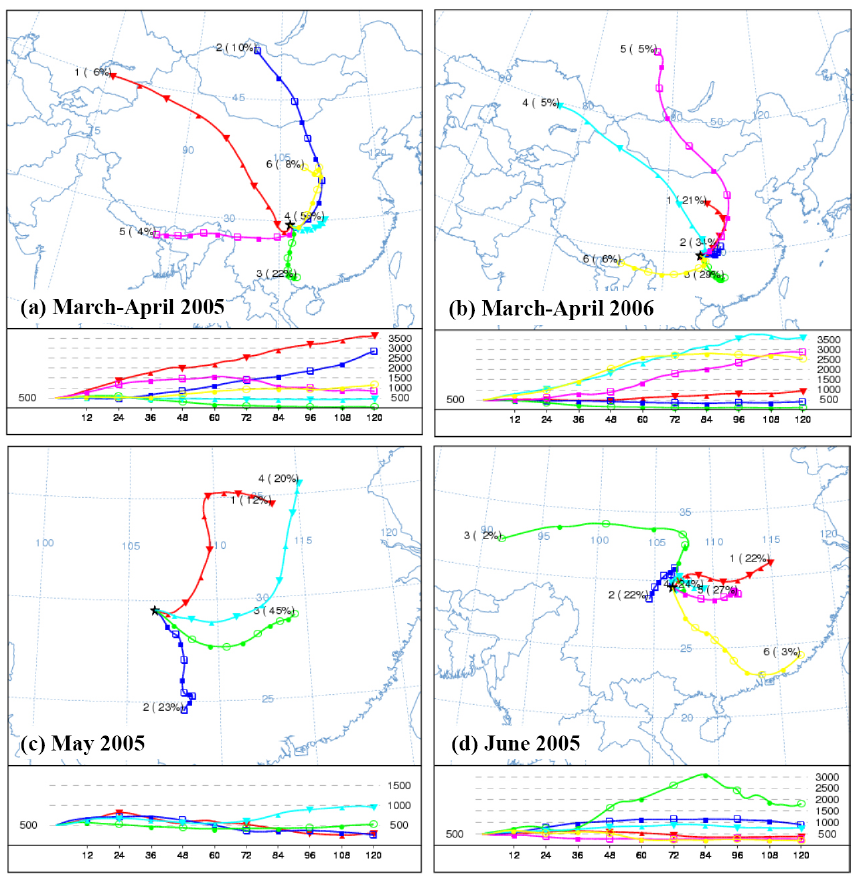
Fig. 5. Clusters of air mass backward trajectories arriving at 500m above ground level at Chongqing for (a) 4 March–6 May, (c) 7–31 May, (d) 1–27 June in 2005 and (b) 3 March–5 May in